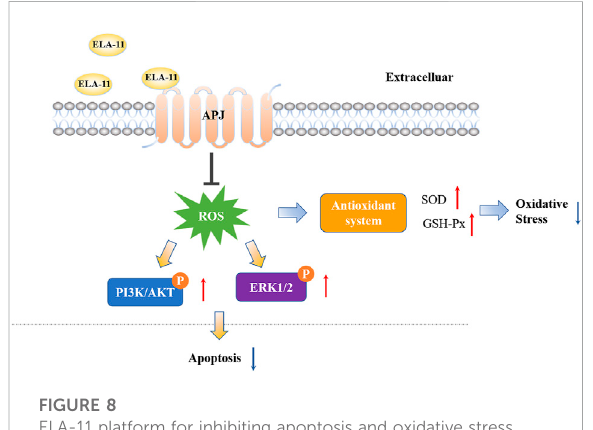
FIGURE 8 ELA-11 platform for inhibiting apoptosis and oxidative stress injury in